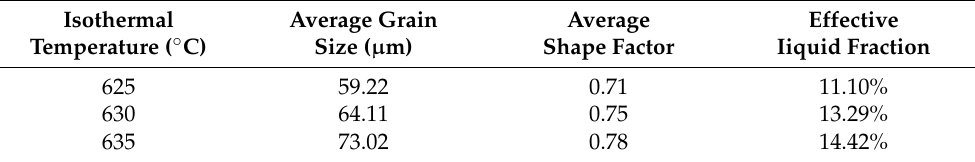
Table 3. Microstructural characteristics of 6063 alloy microstructure processed by SSIT at different isothermal